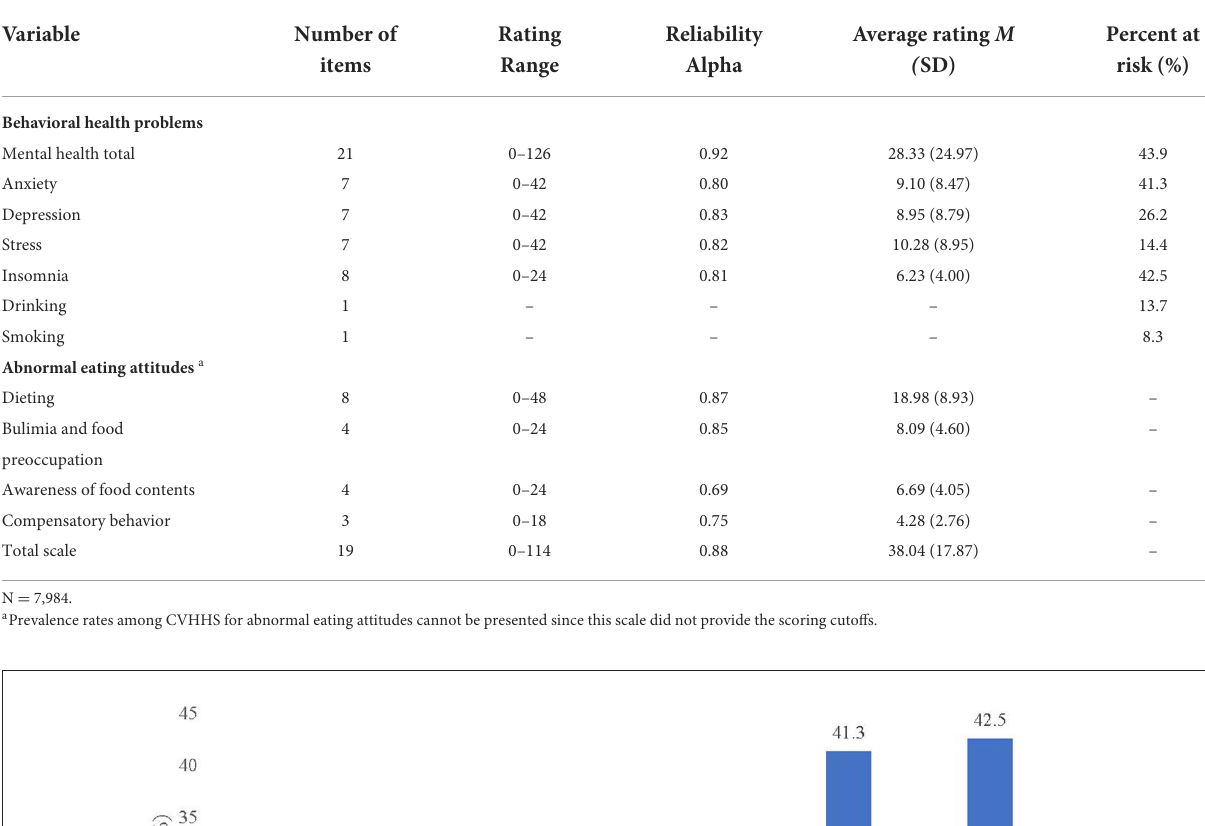
TABLE 2 Psychometric properties of measures of behavioral health risks and abnormal eating attitudes.